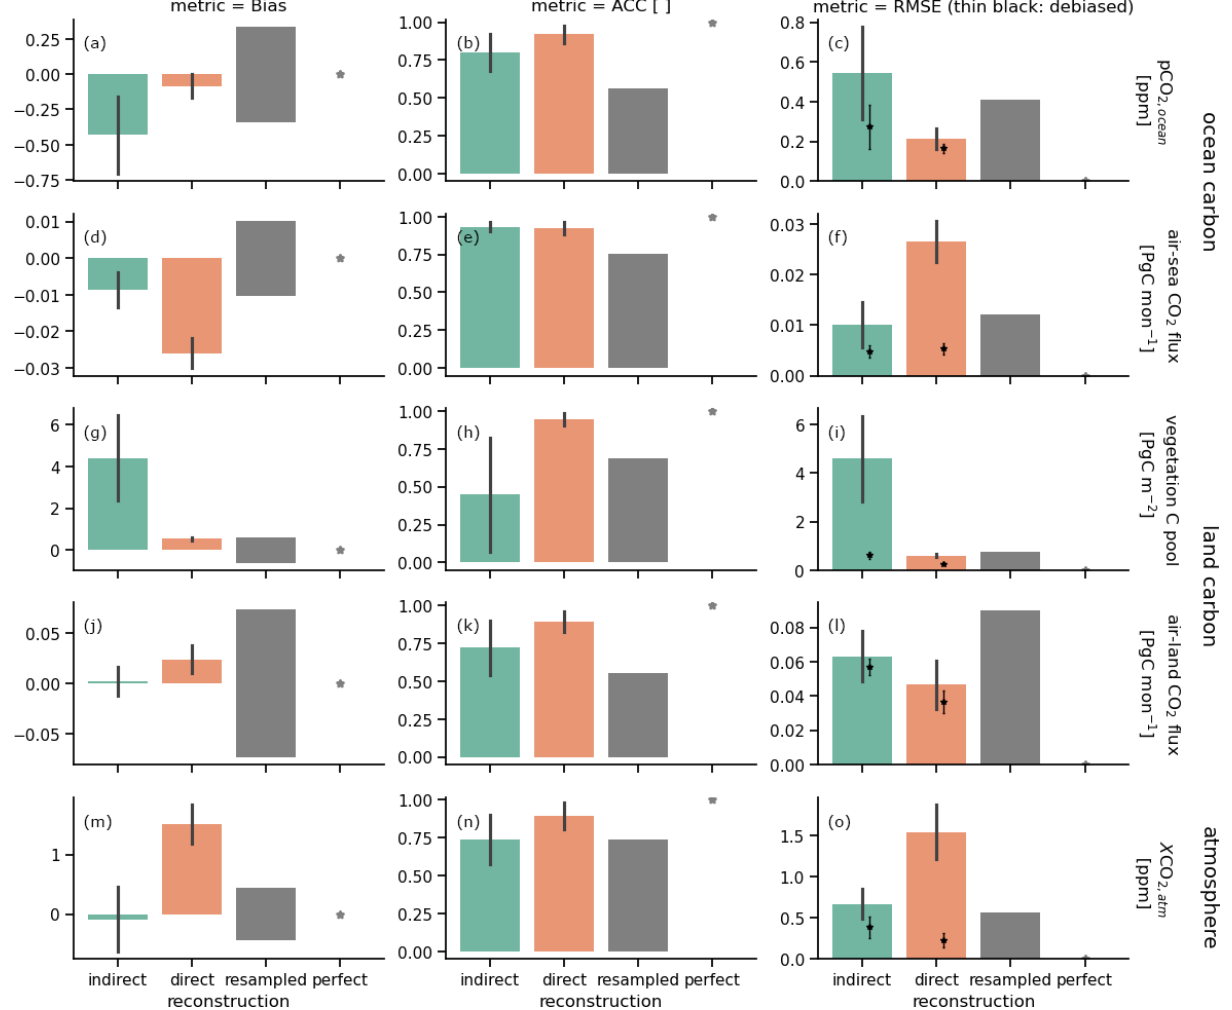
Figure 5. The 10-year running mean annual reconstruction skill in bias ( a , d , g , j , and m ), anomaly correlation coefficient (ACC, b , e , h , k and n ) and root-mean-square error (RMSE, c , f , i , l , and o ) for global aggregation of carbon cycle variables: (a–c) surface oceanic partial pressure of CO 2 , (d–f) air–sea CO 2 flux (negative values indicate carbon uptake by the ocean), (g–i) vegetation carbon pools, (j– l) air–land CO 2 flux (negative values indicate carbon uptake by land) and (m–o) mixing ratio of atmospheric CO 2 . Error bars show ± σ standard deviation of the running skill over time. Columns show different reconstruction methods: indirect (green) and direct (orange). The gray bar marks the magnitude of the 95th percentile for ACC and 5th percentile for bias and RMSE of a random reconstruction skill block- bootstrapped from the target control simulation as an unskillful reference. Gray stars indicate perfect skill. Thin black error bars with crosses show RMSE skill after a mean bias